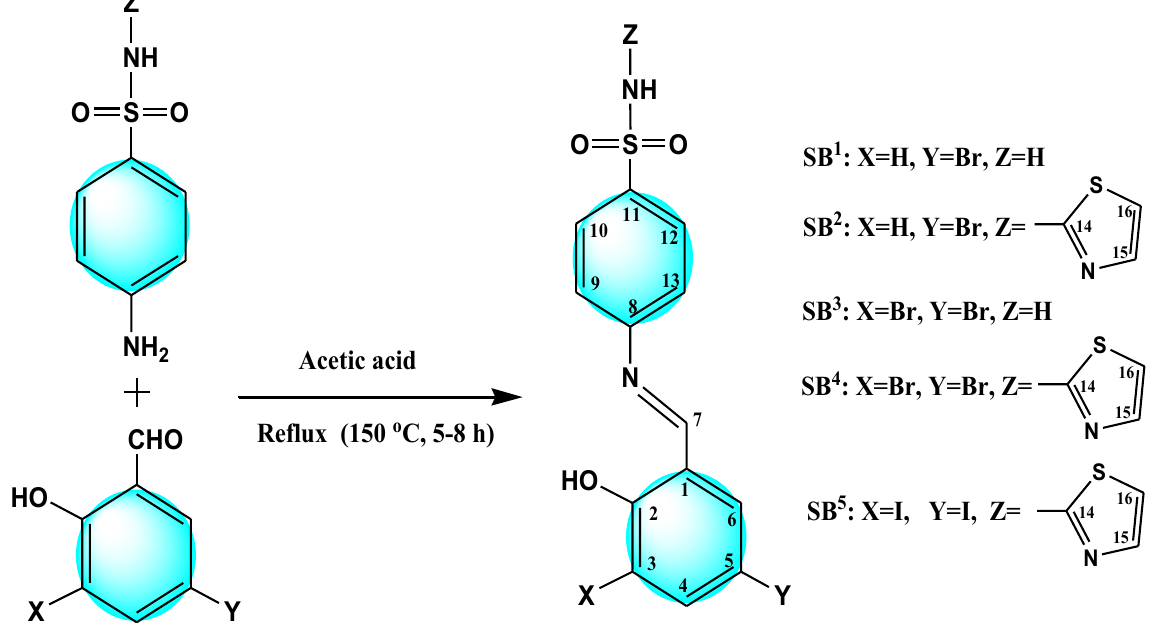
Figure 1. Systematic path for the synthesis of sulfonamide-Schiff base ligands (SB 1 –SB 5 ).